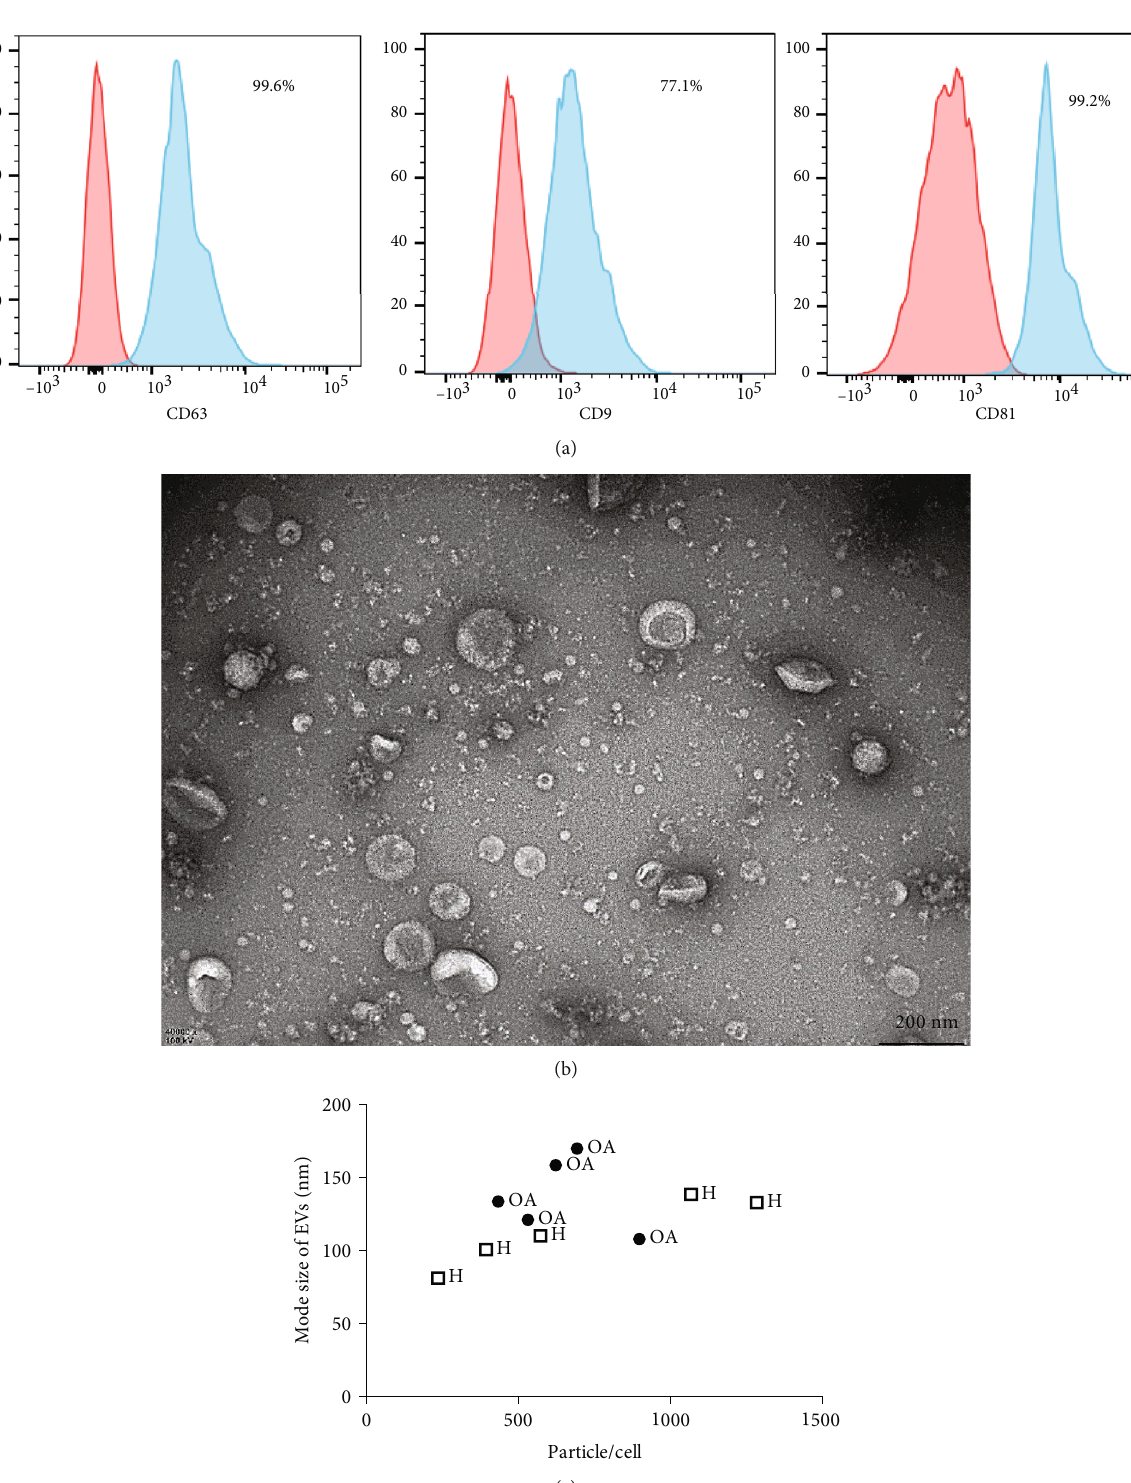
Figure 1: OA-MSC-EV characterization. (a) Flow cytometry of CD63, CD9, and CD81 surface markers (representative OA-EV sample). Red and blue histograms illustrate isotype controls and stained samples, respectively. (b) Transmission Electron Microscopy showing the cup-shape morphology of EVs (representative OA-EV sample, scale bar 200nm). (c) Scatter plot showing size and number of particles/cell analysis of OA and control H-EVs, assessed by nanoparticle tracking